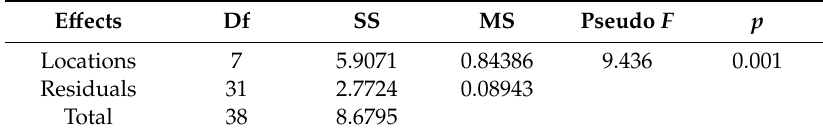
Figure 4. Principal coordinate analysis (PCoA) of sampling units based on Bray–Curtis dissimilarities of double Wisconsin standardization abundances. Table 2. PERMANOVA analysis of double Wisconsin standardization abundances (1000